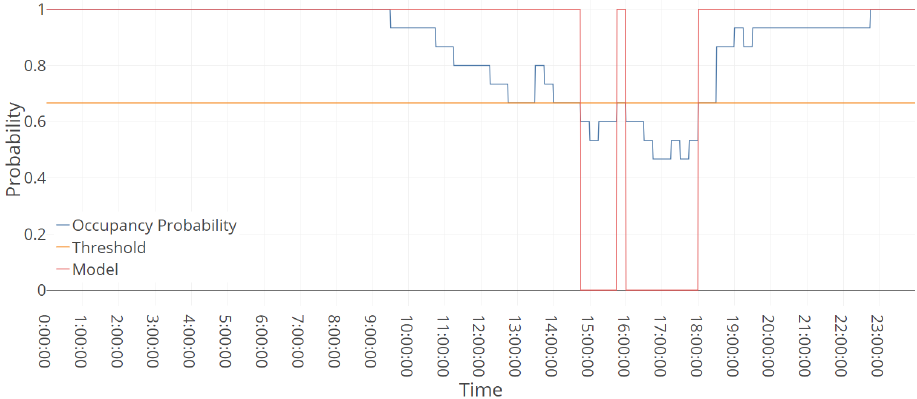
Figure 5. Occupancy probability, threshold, and resulting model for single day, by